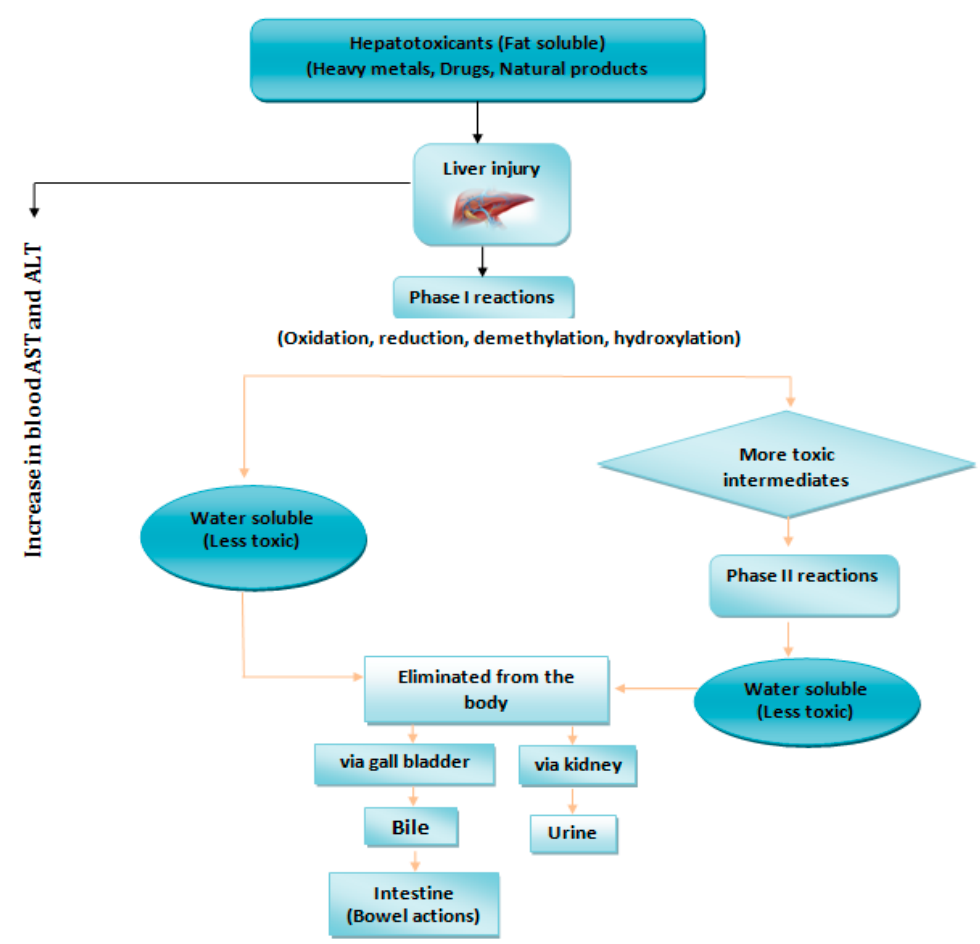
Figure 4. Biotransformation of hepatotoxicants.